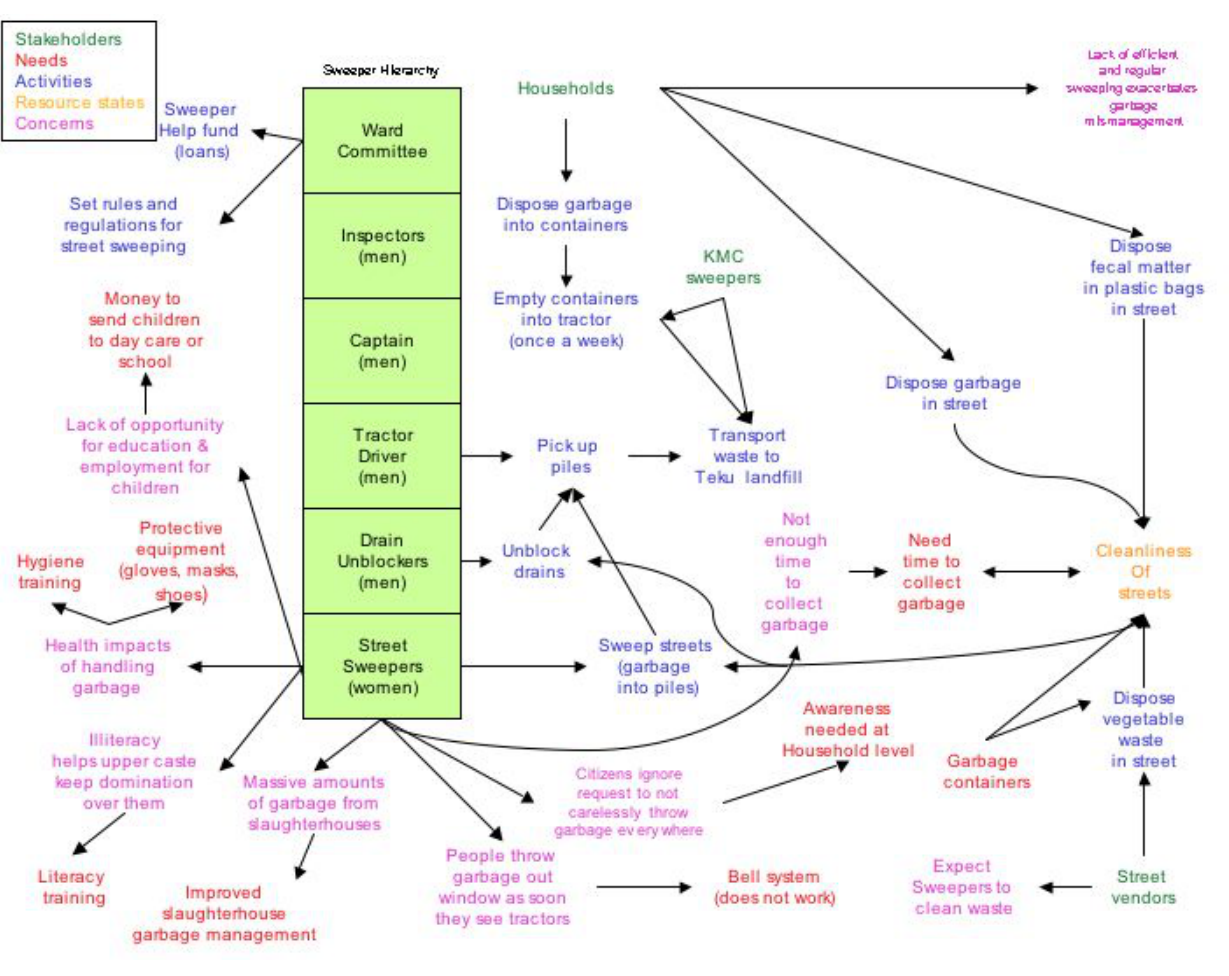
Fig. 6 . Issues and influences - sweeper